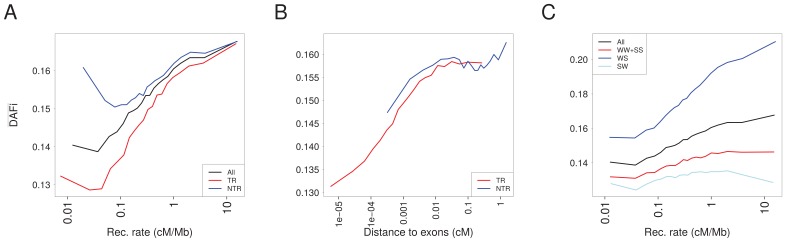
DAFi¯in 1000G populations as a function of recombination rate for various sites.(A) DAFi¯ in transcribed regions (TR, red) and in non-transcribed regions (NTR, blue) are compared to DAFi¯ computed over all sites (all, black). DAFi¯converges to the same values for both TR and NTR for high-recombination rates where BGS does not act. (B) DAFi¯ for TR and NTR regions increases with recombination distance to exons. In the interval between ~0.001 and~0.1 cM where SNP can be either in TR or NTR regions, DAFi¯s are similar for TR and NTR. (C) Comparison between DAFi¯ computed for three gBGC categories of sites. In regions of high-recombination rate, S alleles are favored by gBGC, such that DAFi¯ for WS sites increases, and DAFi¯ for SW sites decreases with recombination. As expected, DAFi¯ values diverge for different gBGC sites in genomic regions with high-recombination rate.